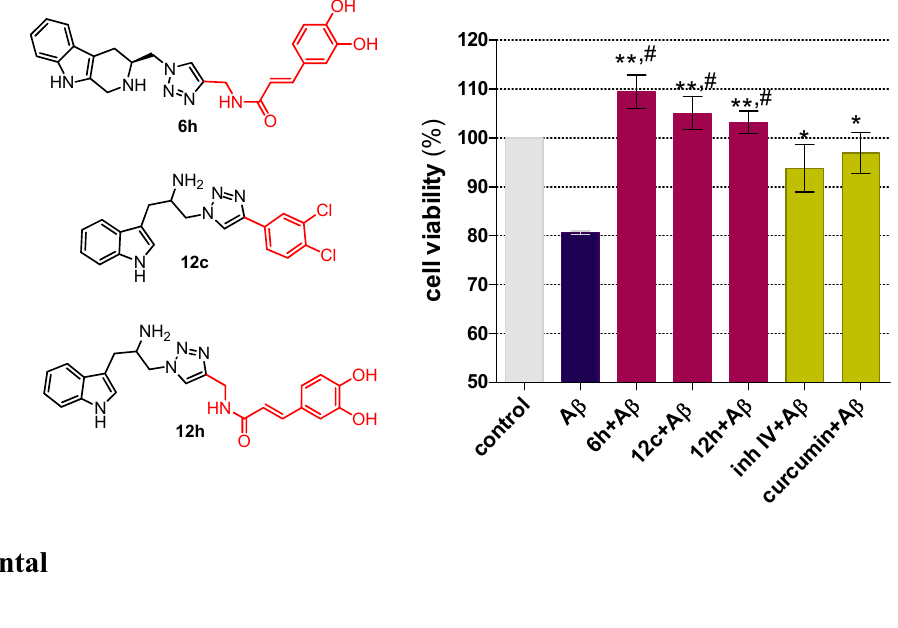
Figure 7. The protective effect of multifunctional compounds against A β -induced neuronal cell death by MTT viability assay at 1 μ M, t -test * p < 0.05, ** p < 0.01 vs. A β treated cells and # p < 0.05 vs. BACE1 inhibitor